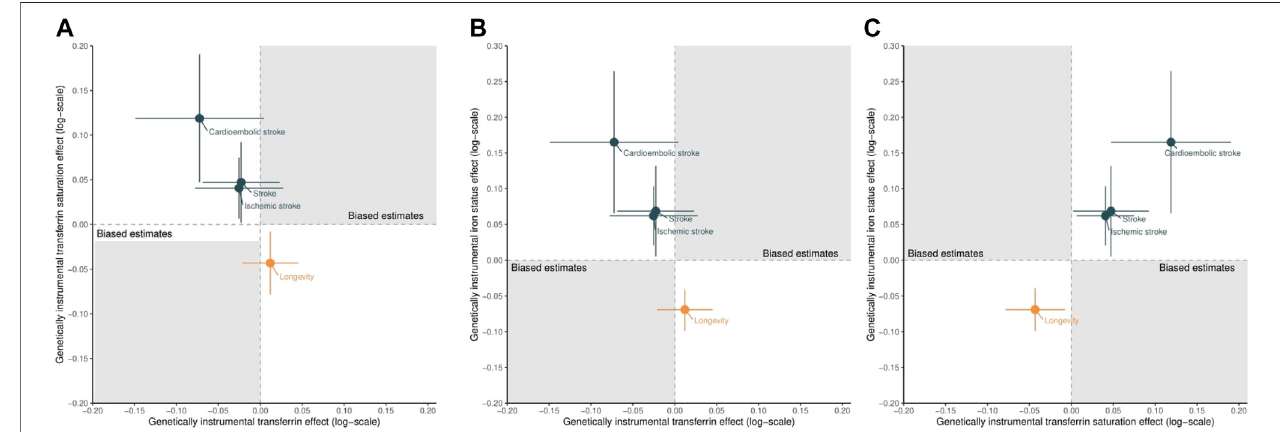
FIGURE 4 | Scatter plots of the estimated effects of genetically predicted higher transferrin versus higher transferrin saturation (A) , higher transferrin versus higher iron status (B) , and higher transferrin saturation versushigher iron status (C) on stroke (including ischemic and cardioembolicstroke)and longevity. Pointslocated in the gray area indicate the presence of selection